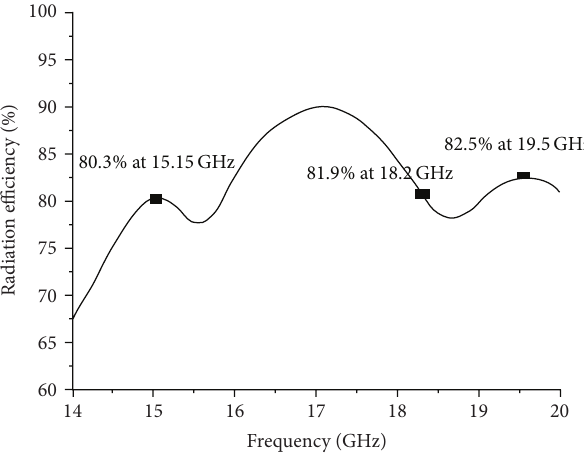
Figure 4: Simulated and measured reflection coefficients of the proposed antenna prototype.